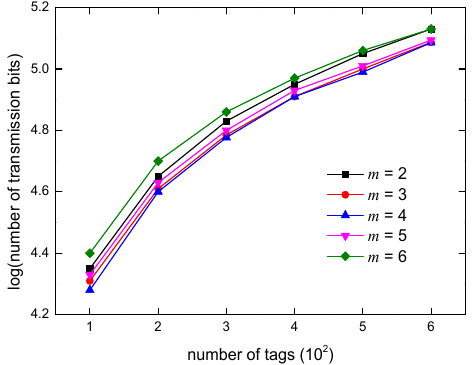
Figure 8. Comparison of data transmission.